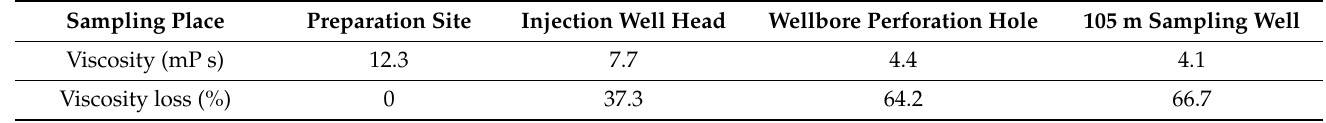
Table 1. Polymer solution viscosity loss